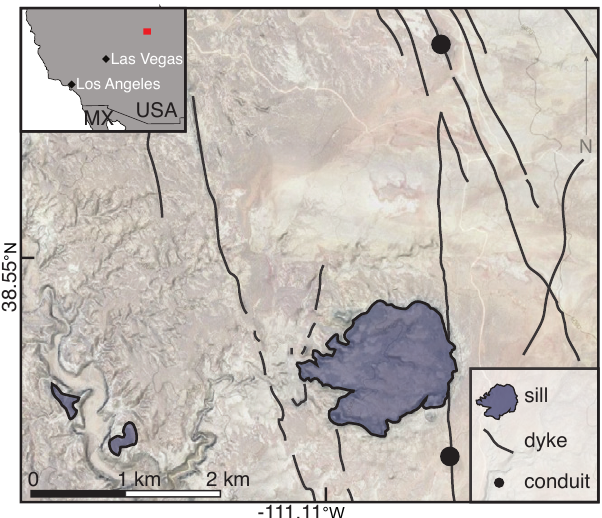
Figure 1: Magmatic storage and transit structures of the San Rafael Volcanic Field, Utah, USA. This figure illus- trates the complicated relationship between sills (pur- ple shading), dykes (black lines), and the surface ex- pression of volcanism (mapped vents/conduits, shown as black dots). We note the broader distribution of sub- surface features (dykes and sill) compared to the con- duits, which fed eruptions at the surface. All figure coor- dinates are reported in degrees lat/long (WGS ’84). Map